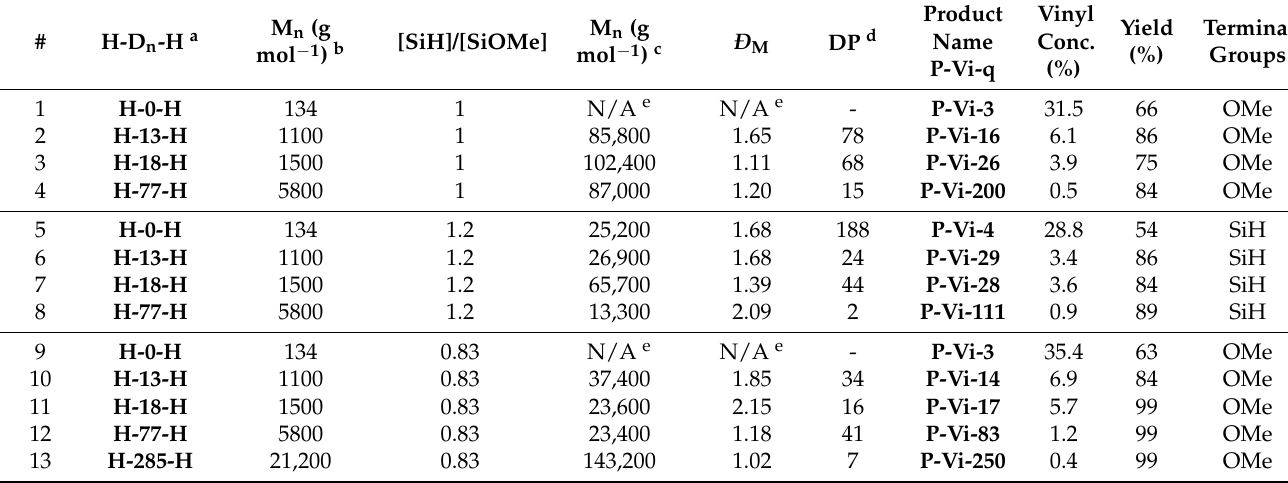
Table 1. The synthesis of spatially controlled vinyl silicones with SiH or SiOMe as terminal functional groups.